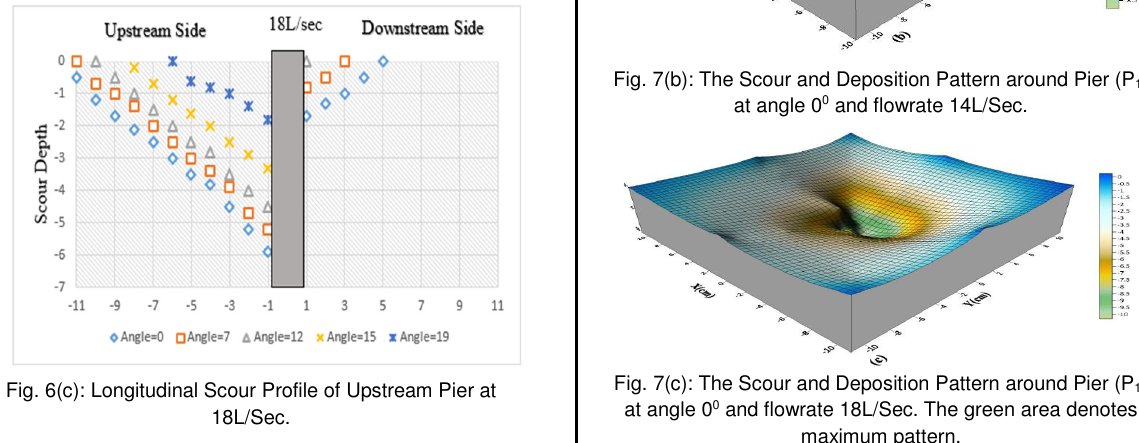
Fig. 6(c): Longitudinal Scour Profile of Upstream Pier at